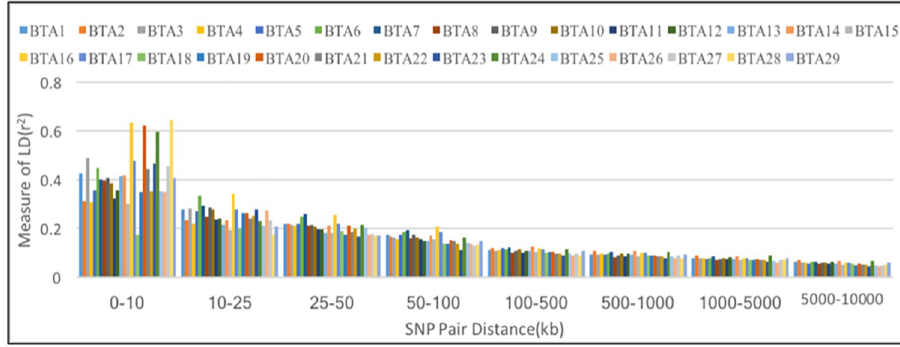
Fig 2. The mean r 2 as distance between pairs of SNP up to 10 Mb for the genome across autosomes.